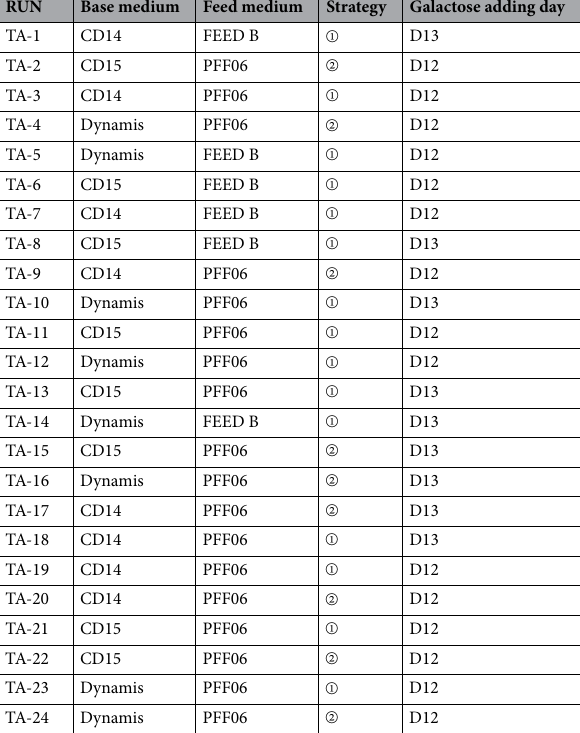
Table 3. The design of experiment for 24-run experiment in